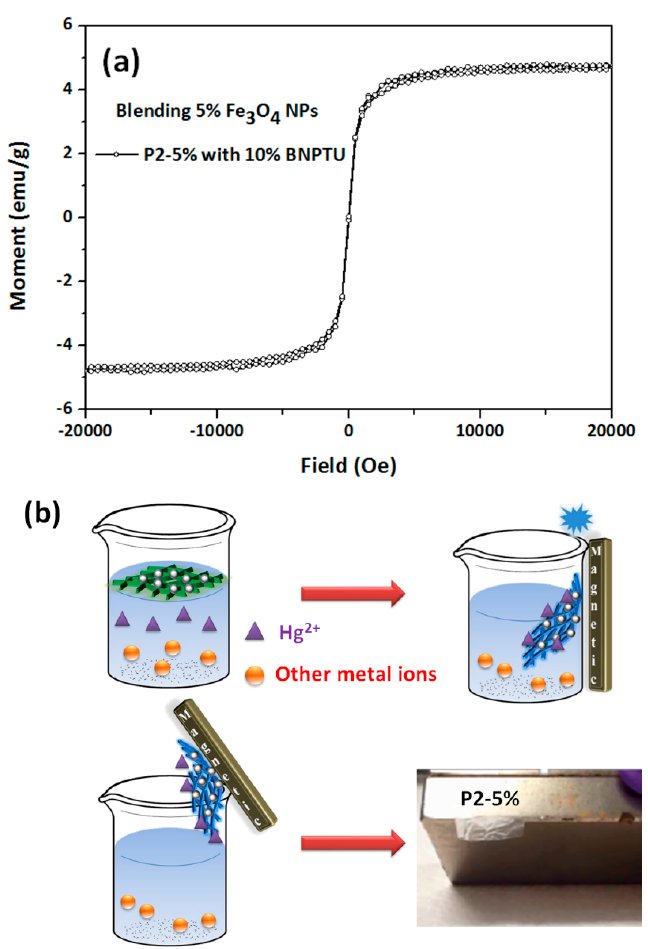
Figure 12. ( a ) Hysteresis loops of P2-5% ES nanofibers (5 wt % Fe 3 O 4 NPs) measured at 25 °C. ( b ) Schematic of a filter sensory membrane prepared from P2-5% ES nanofibers composed of poly(NIPAAm- co -NMA- co -AA)), BNPTU, and Fe 3 O 4 NPs blends to simultaneously chelate and sense